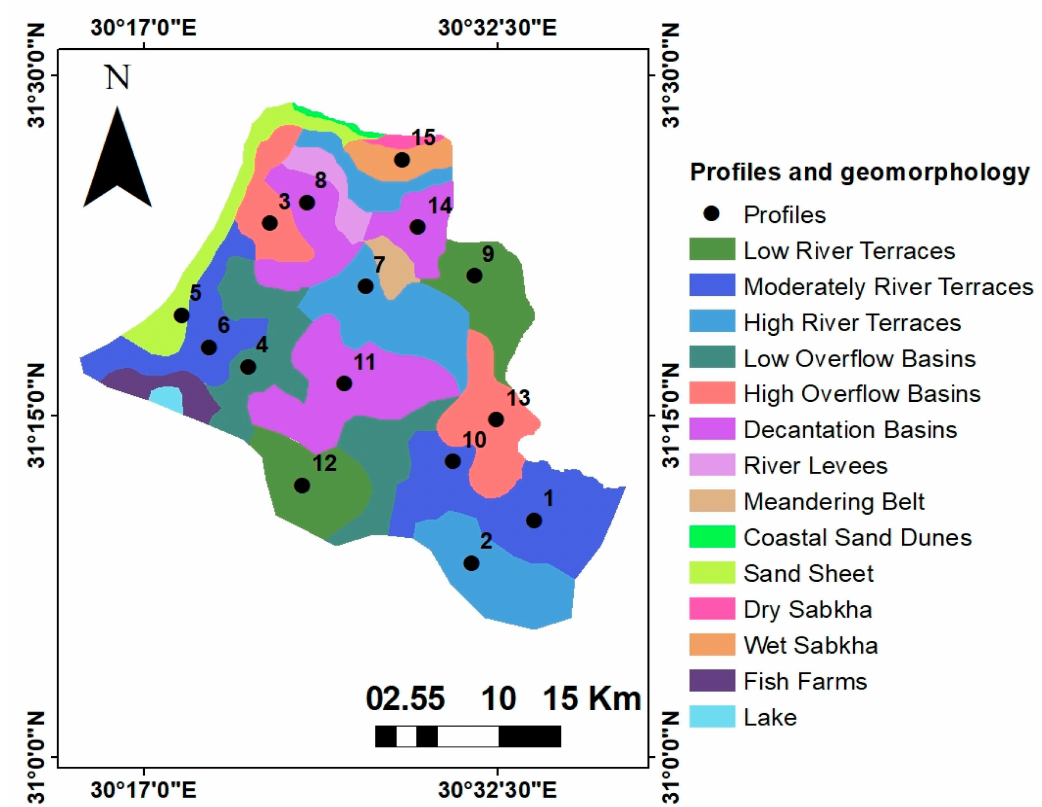
Figure 2. Profiles locations within the study